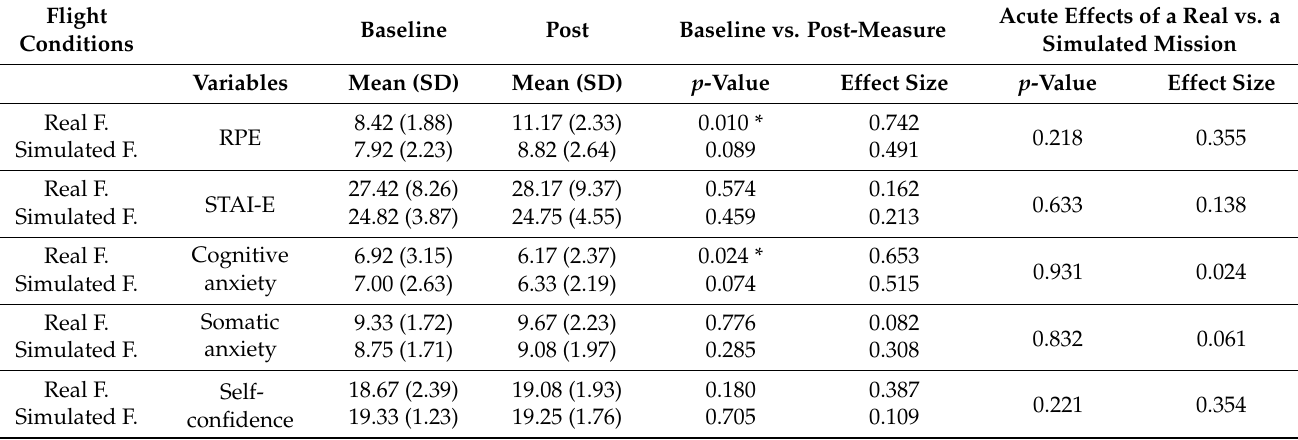
Table 3. Acute effects of a real vs. a simulated flight mission on the rating of perceived exertion, anxiety and self-confidence. Flight